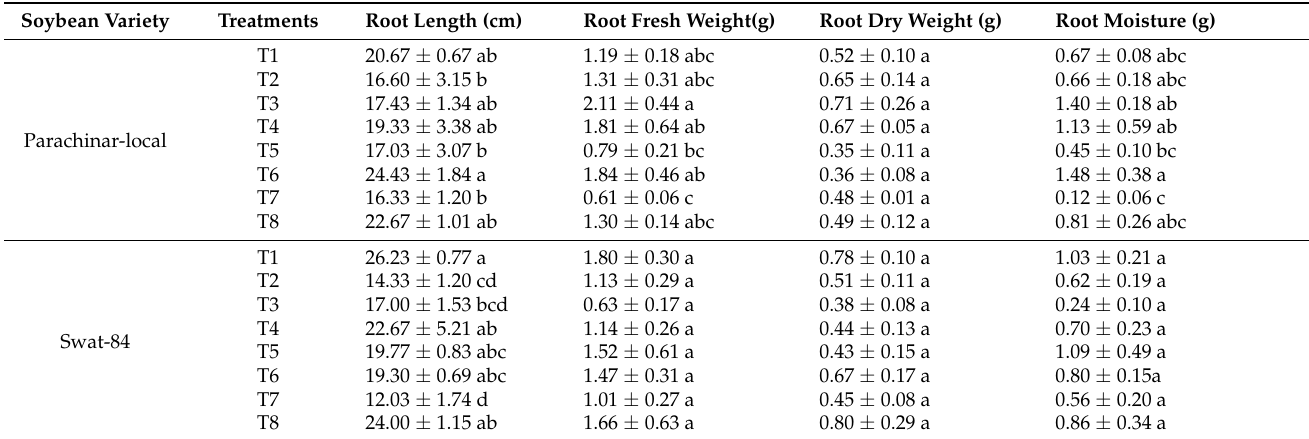
Table 2. Changes in root growth of both